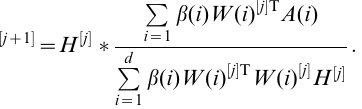
, and g ½ j (cid:2) , with (cid:3) representing H W ( i )